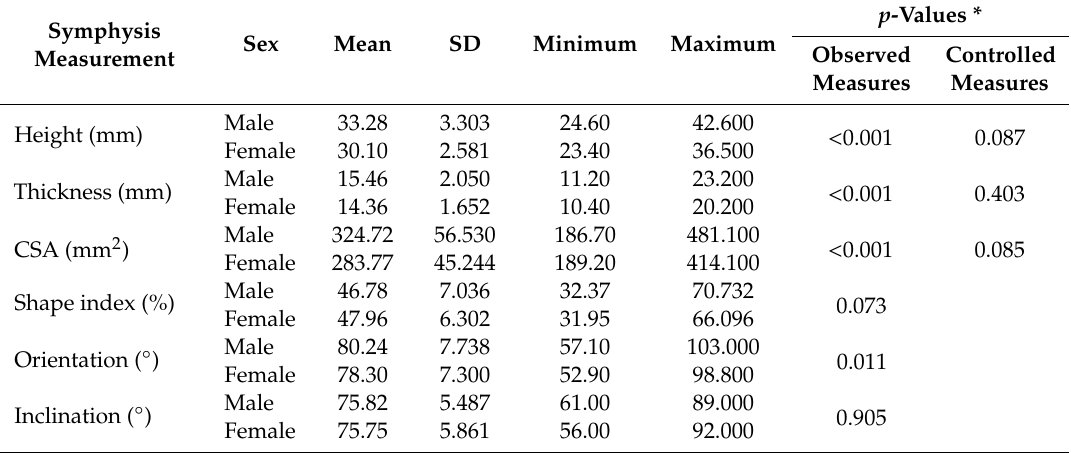
Table 6. Morphometric characteristics of the male and female symphysis (males n = 203, females n = 216).